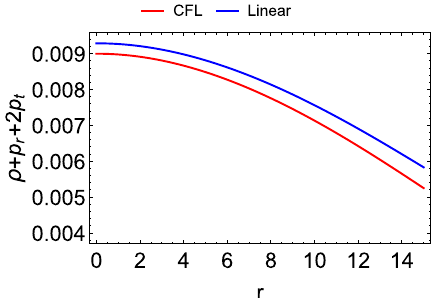
Fig. 10 Variation of the strong energy condition as a function of the radial